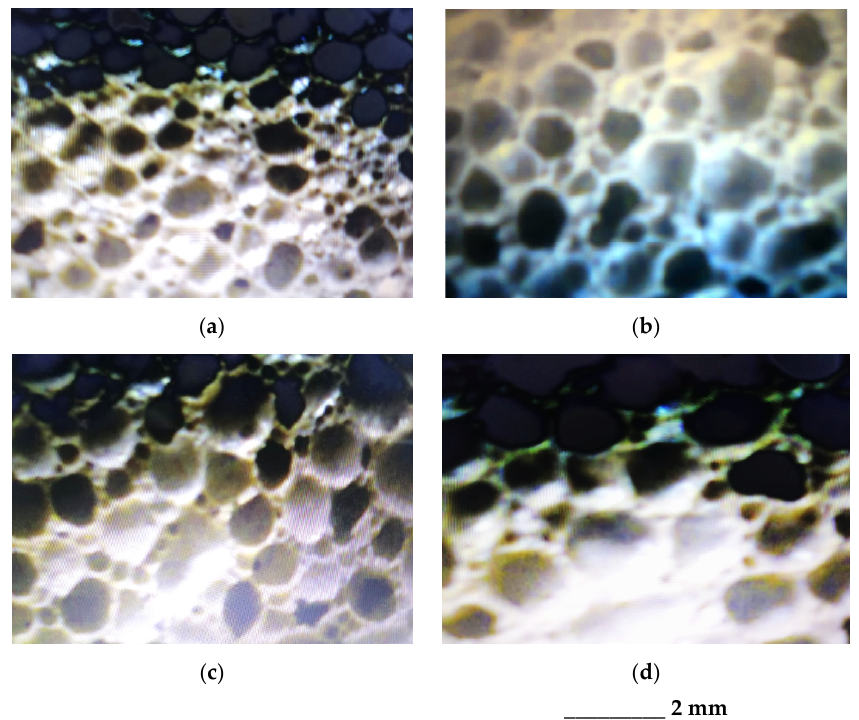
Figure 3. Microstructural configuration of the glass foam samples corresponding to: variant 1 ( a ); variant 2 ( b ); variant 3 ( c ) and variant 4 ( d